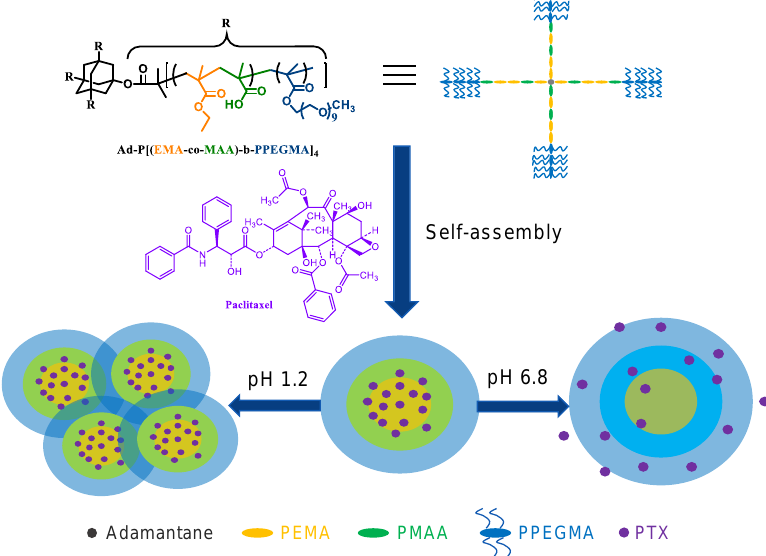
Scheme 1. Schematic formation of nano-carriers and the illustration of pH-dependent drug